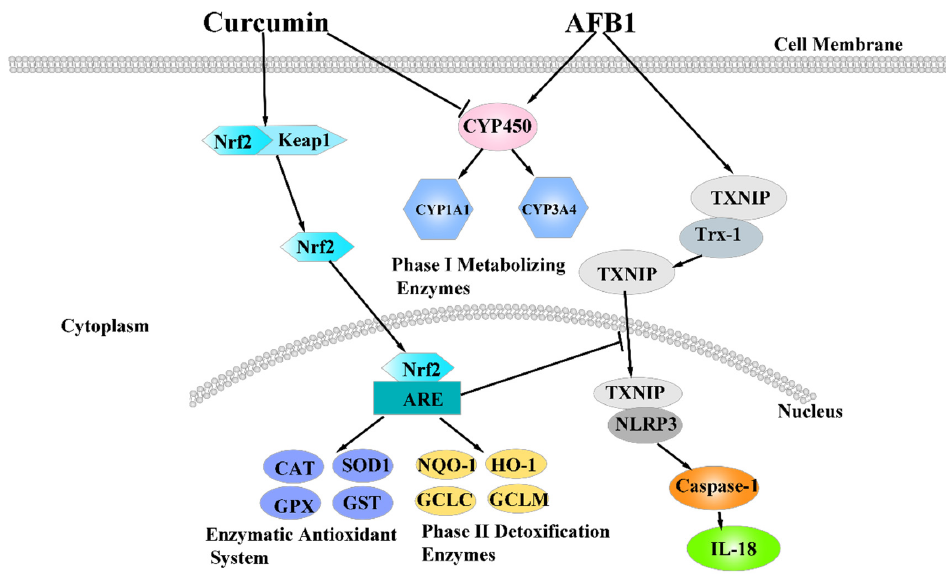
Figure 9. The mechanism of dietary curcumin alleviated liver damage induced by AFB1. Supplementary Materials: The following are available online at https://www.mdpi.com/article/ 10.3390/foods10123086/s1, Table S1 shows the experiment design; Table S2 shows the ingredient composition and nutrient content of the basal diet (%, as-fed basis); Table S3 shows the accession number, Primer sequence, and product size of target